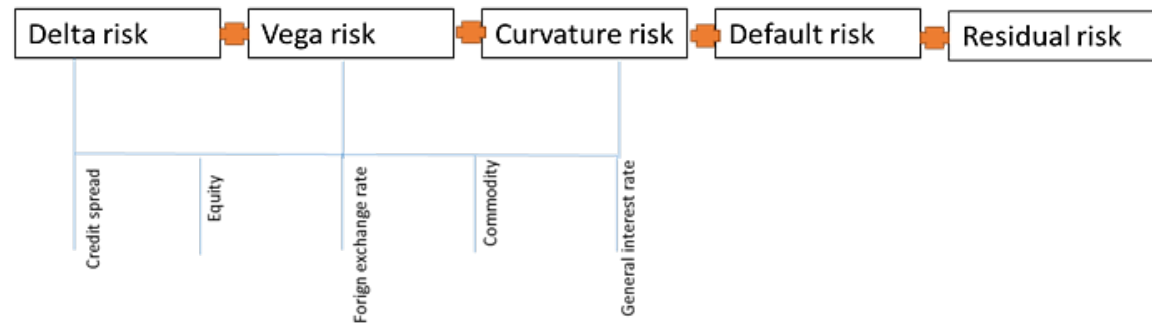
Figure 2. The different risk factors of the revised standardized approach